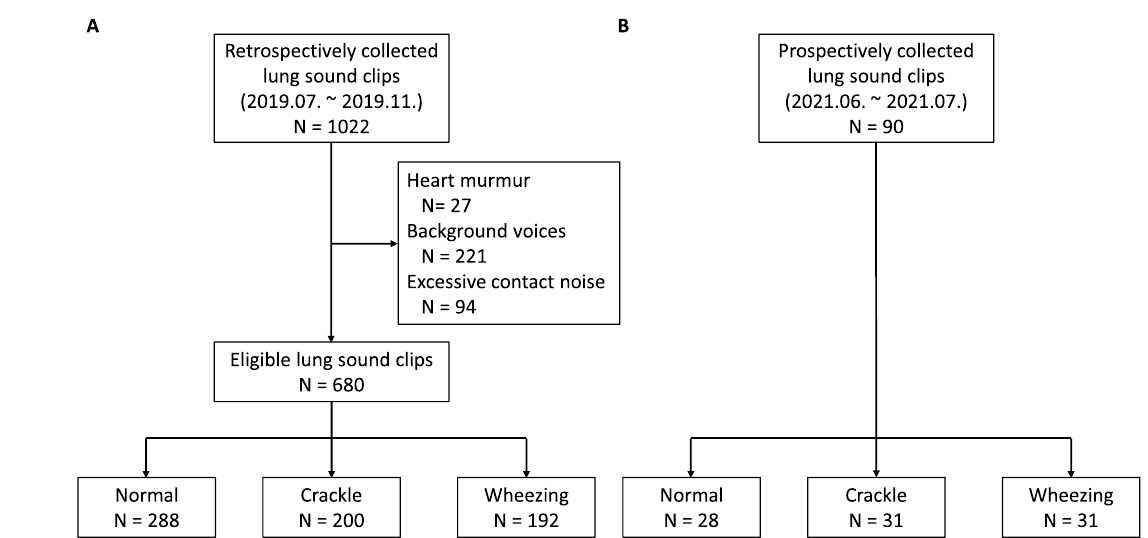
Figure 1. Study flowchart of the collection of lung sound data for ( A ) the training and internal validation set and ( B ) the prospective validation